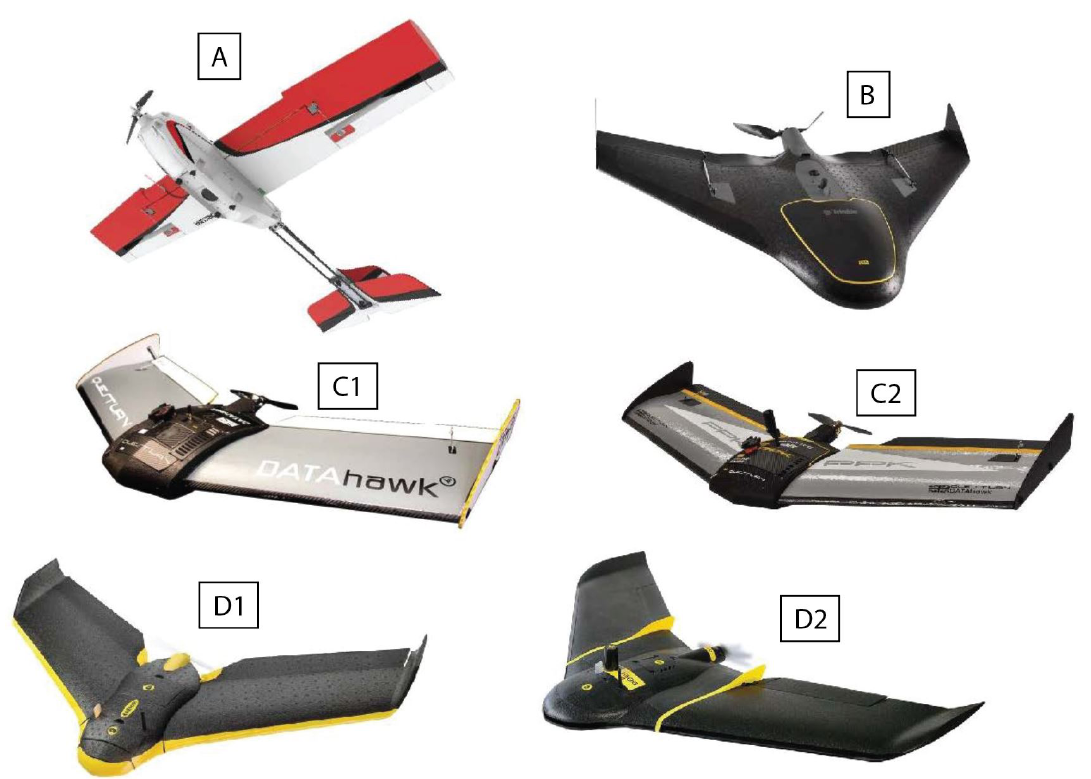
Figure 4. Examples of fixed wing UAS: ( A ) Precision Hawk Lancaster 5; ( B ) Trimble UX5; ( C1 ) QuestUAV DATAhawk; ( C2 ) QuestUAV DATAhawk PPK; ( D1 ) senseFly eBee; ( D2 ) senseFly eBee